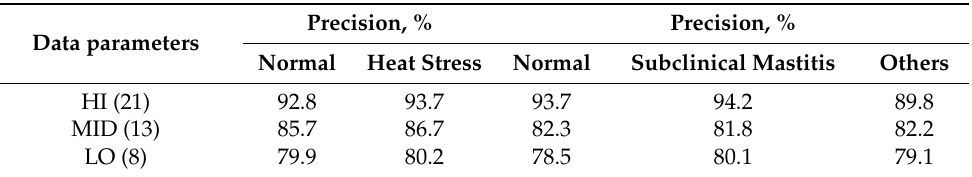
Table 3. The precision of the effect of classification using the data-mining hub with a different number of parameters: HI (21 parameters), MID (13 parameters), and LO (8